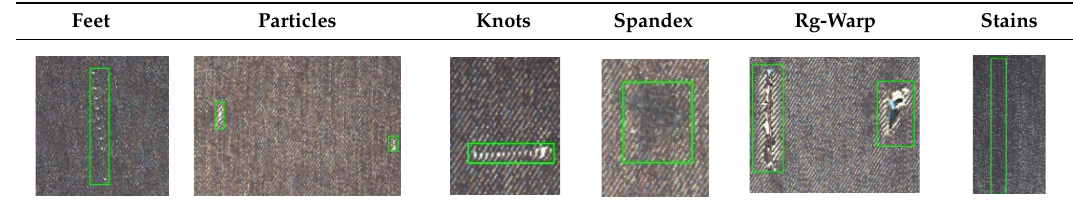
Table 1. Samples of different classes of Fabric Defects (FBDF).